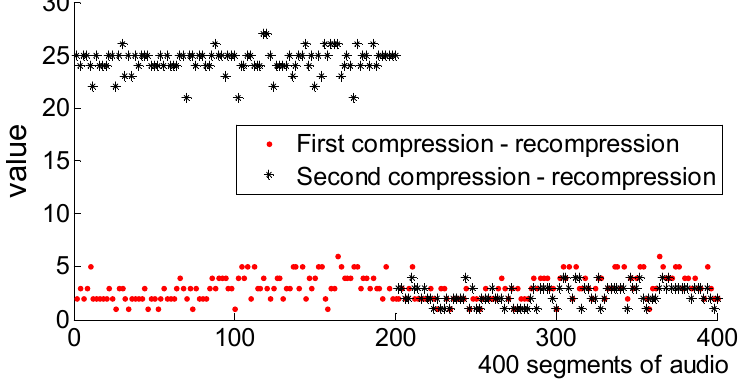
Figure 5. Randomly select the mean of the difference between 400 AAC audio.